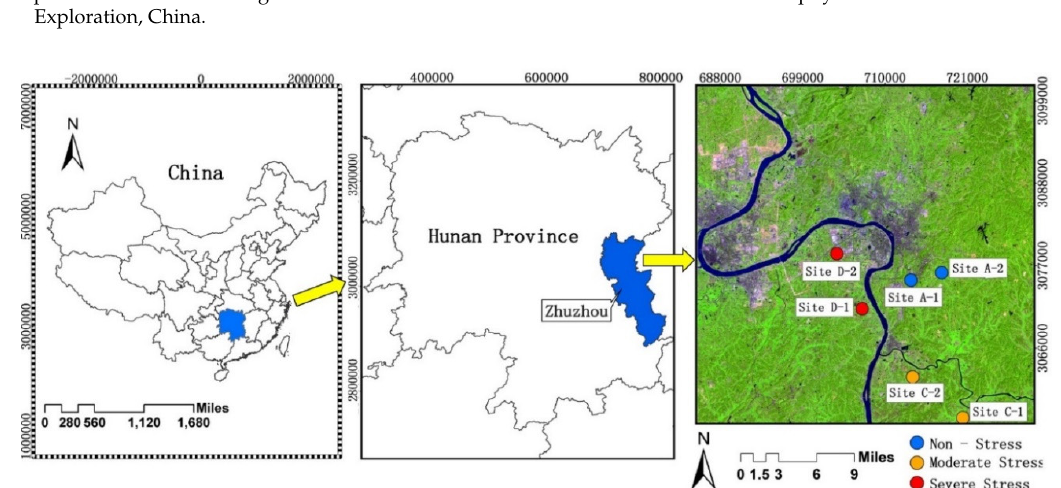
Figure 1. Location map of the six study sites in Zhuzhou, Hunan Province, China.